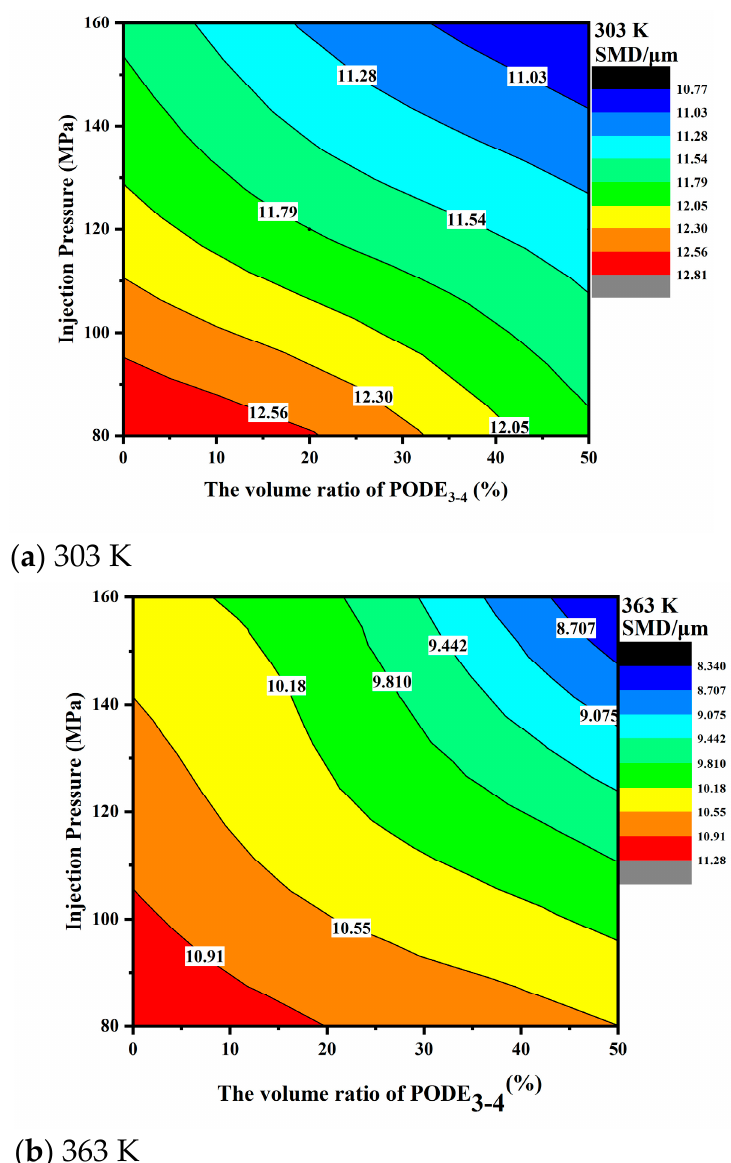
Figure 15. The influence of different temperature and IPs on the SMD of test fuels’ droplets.